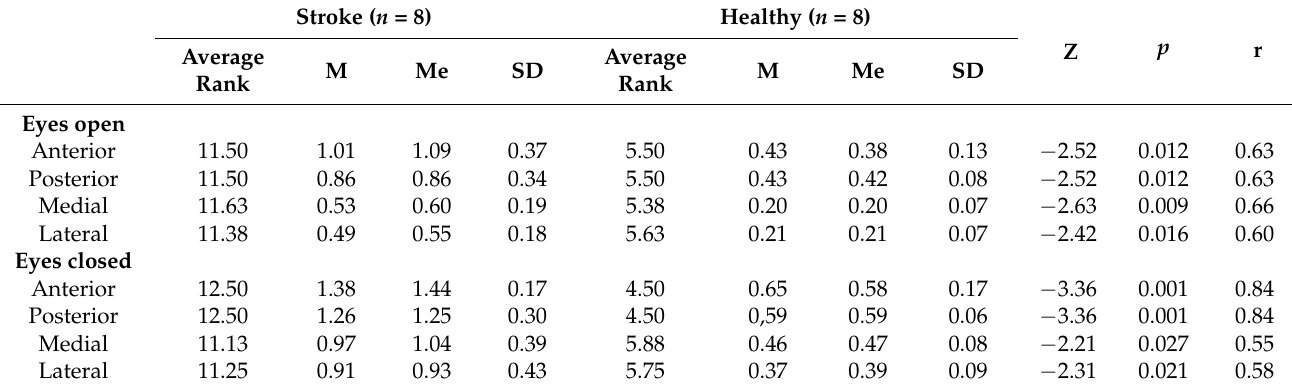
Table 3. Comparison of stroke patients and healthy patients in terms of the parameters measured. Stroke ( n = 8) Healthy ( n = 8)